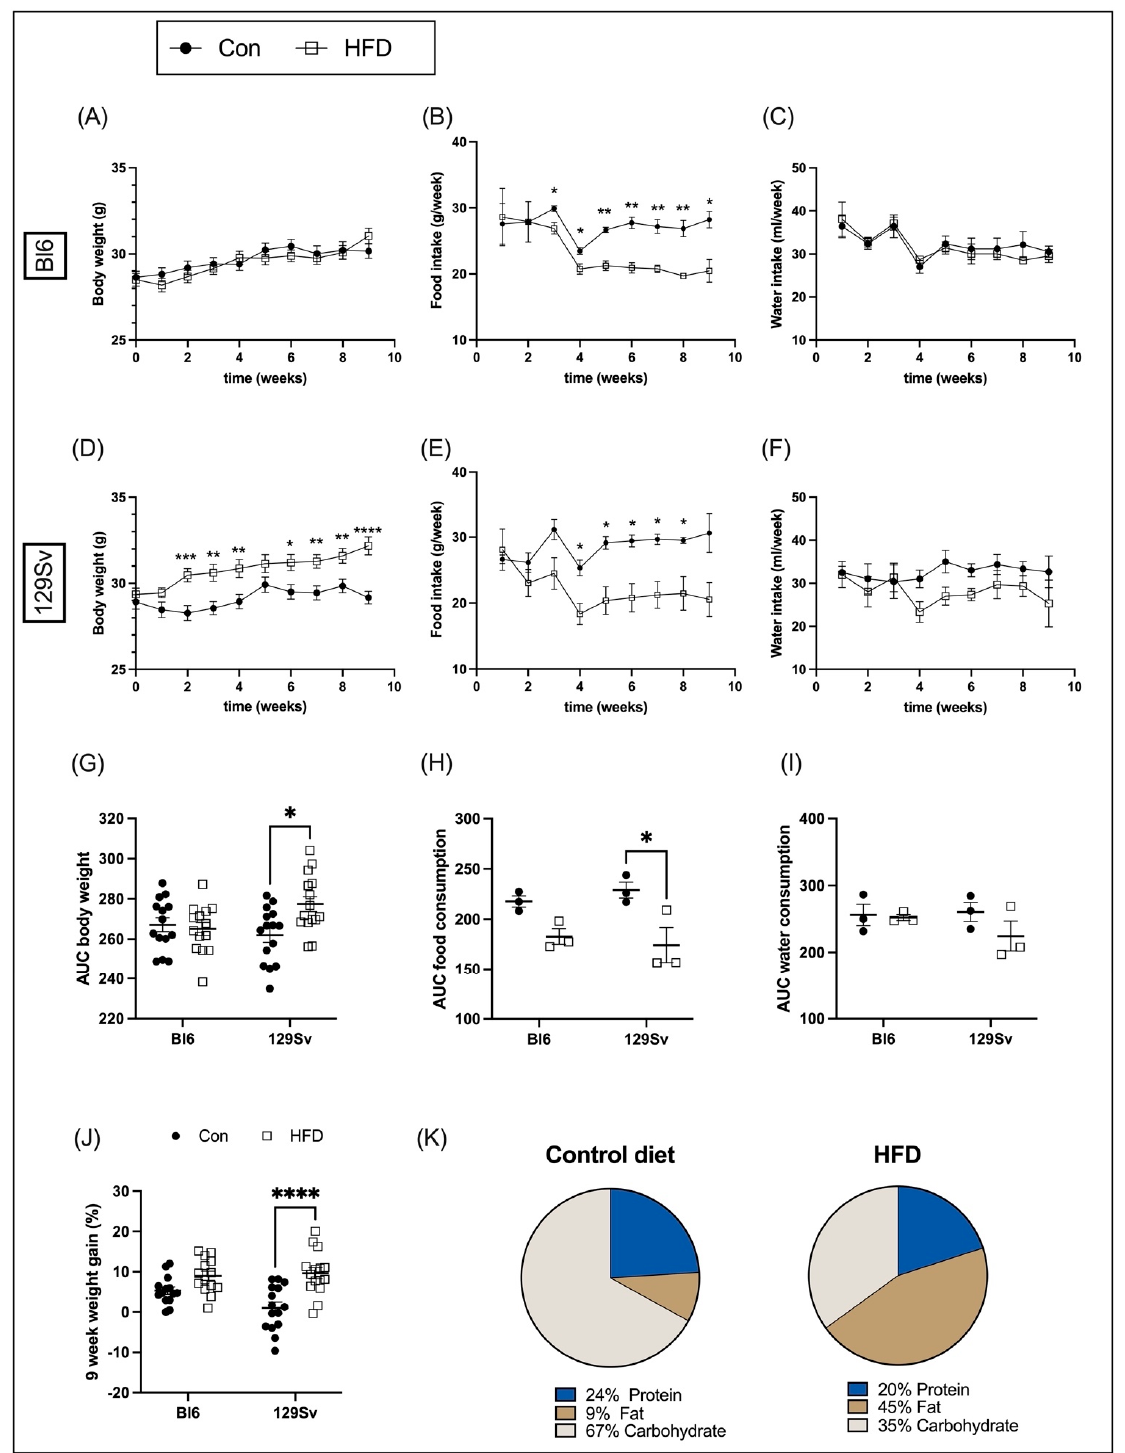
Figure 1. Effects of HFD on body weight and food and water intake in Bl6 and 129Sv mice. Weekly body weight measurements of Bl6 ( A ) and 129Sv ( D ) mice during 9 weeks of HFD experiment. Weekly measurements of food ( B , E ) and water ( C , F ) intake of Bl6 ( B , C ) and 129Sv ( E , F ) mice. AUC of body weight ( G ), food ( H ), and water ( I ) intake. ( J ) Nine-week weight gain. ( K ) Macronutrient content of control diet and HFD. Data are expressed as mean values ± SEM. * p ≤ 0.05, ** p ≤ 0.01, *** p ≤ 0.001, **** p ≤ 0.0001 (diet